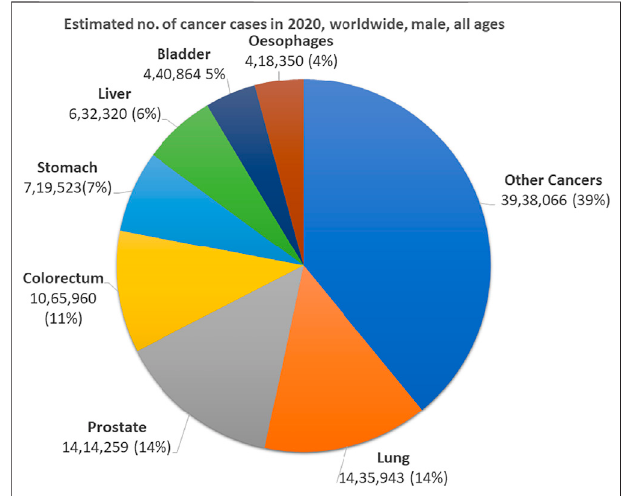
FIGURE 1 | Pie chart depicting the distribution of global prevalence of the seven most frequent cancers in 2020 for all ages. Adapted from the data published by Wild et al.